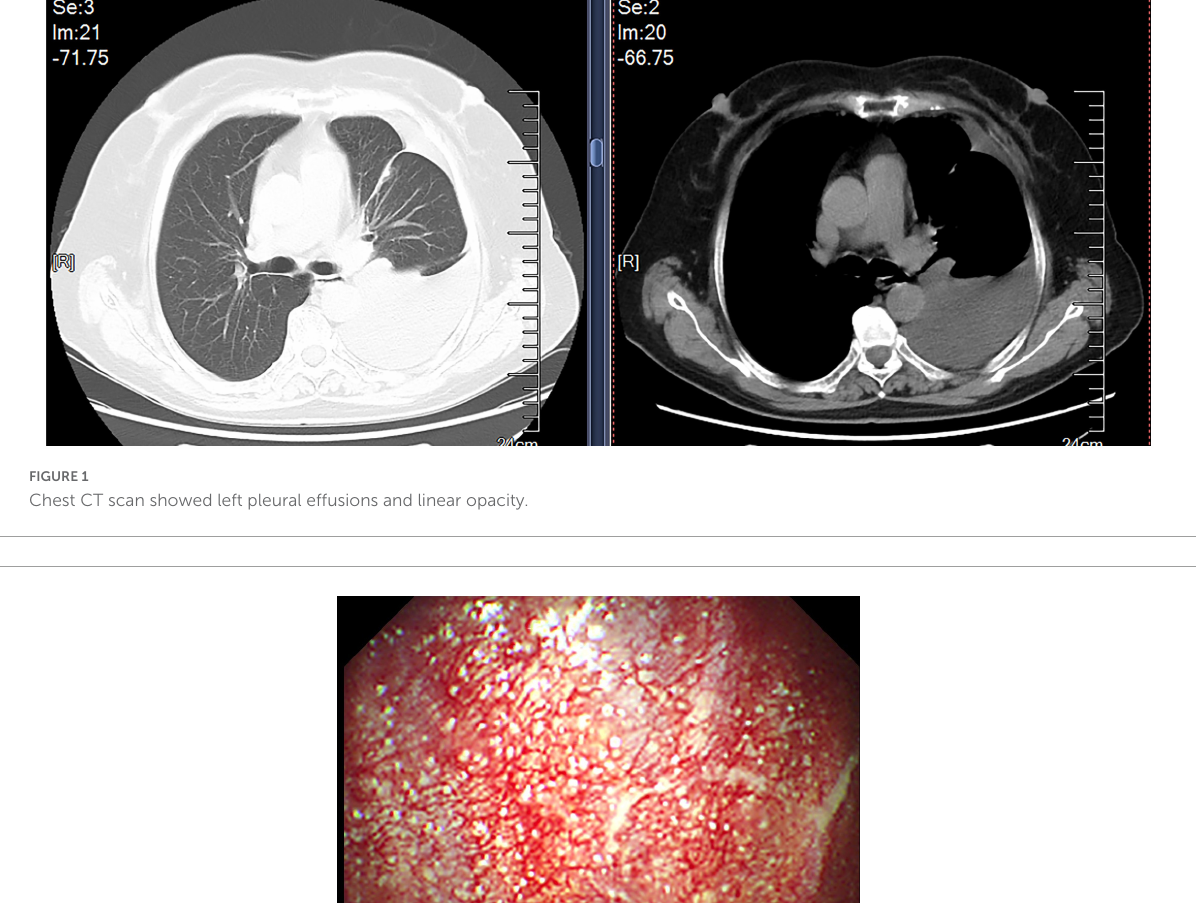
treatment of sarcoidosis and also the most commonly used first-line therapy (17). Corticosteroids hamper the formation of granulomas and, as a result, are largely efficient against most active clinical manifestations (18). For recurrent or symptomatic patients of sarcoidosis with pleural involvement, corticosteroids are required (19). Asymptomatic pleural effusions are likely